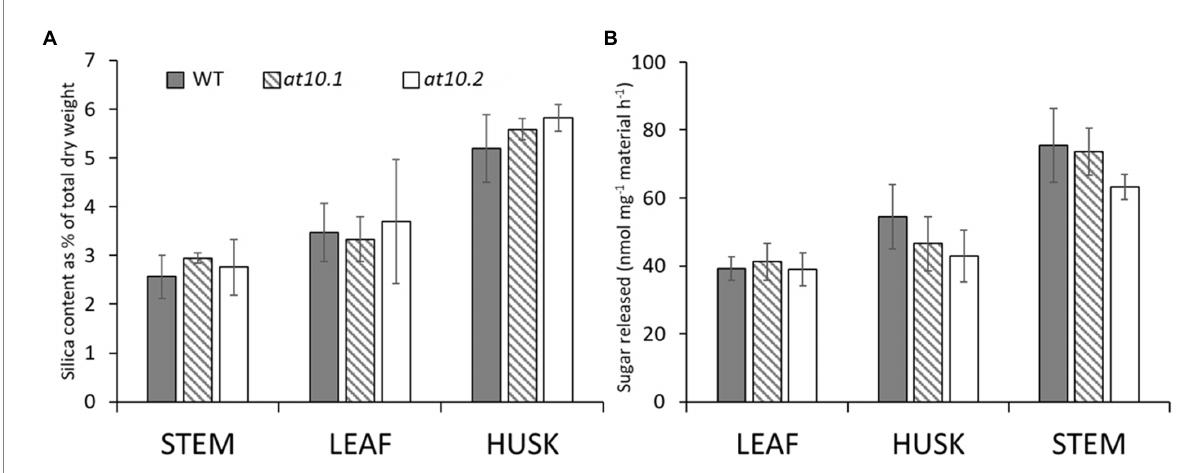
FIGURE 7 Silica and saccharification analysis. (A) Analysis of silica content measured by X-ray fluorescence and (B) saccharification analysis of leaves, husks and stems from wild type (grey bars) and OsAT10 mutant OsAT10.1 (Hatched bars) OsAT10.2 (Empty bars) The ground material for saccharification analysis was digested with a commercial cellulase for 8 h at 50 ° C following a mild water pre-treatment. Student’s t-test was run between WT and both mutants to check for